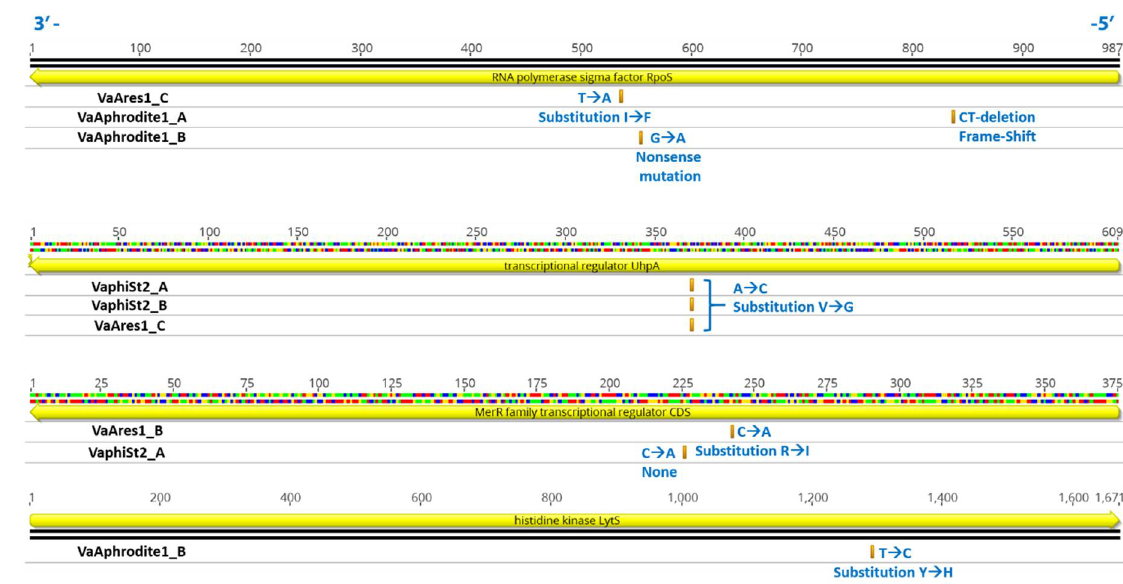
Figure 5. Schematic representation of nucleotide sequences of four CDSs and their orientation, involved in transcriptional regulation of V. alginolyticus , and their SNPs as presented in the text. Yellow represents CDS; orange, SNP positions; and blue, information of SNPs and protein effects in resistant bacteria VaAphoridte1 (A, B), VaphiSt2 (A, B), and VaAres1 (B, C). Orientation of the genome is also shown with blue numbers.